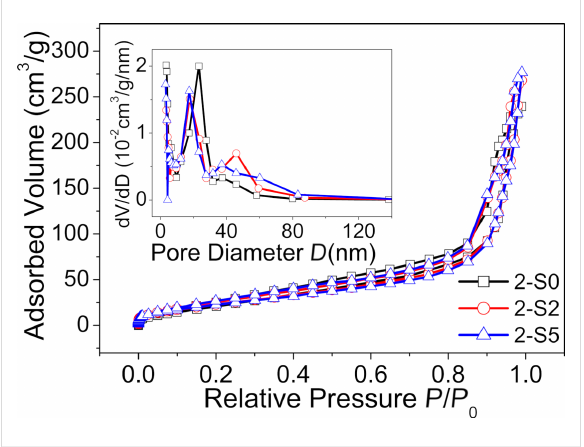
Figure 8: Nitrogen adsorption–desorption isotherms of samples 2-S0, 2-S and 2-S5. The inset shows the pore size distribution calculated using the BJH